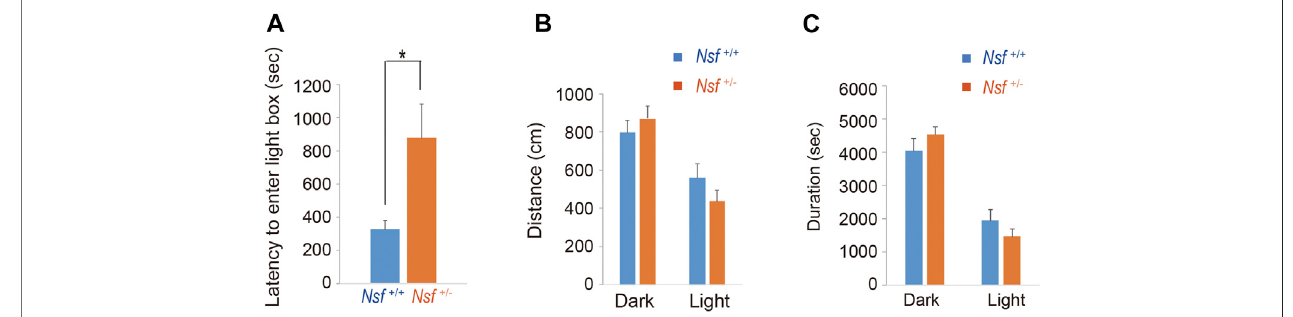
FIGURE 4 | Nsf +/ − mice show anxiety in the light/dark box test. (A) The latency to the fi rst entry of the light box. (B) The total distance between the light and dark boxes. (C) The time spent in the light and dark boxes. ( n (cid:1) 11 for each genotype, mean ± SEM. Student ’ s t-test. * p < 0.05).